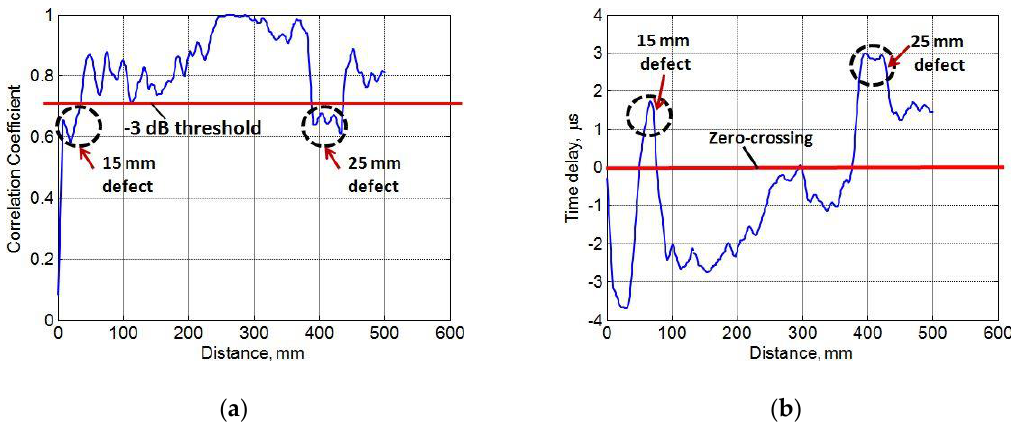
Figure 9. Defect estimation using cross-correlation procedure on wavelet-processed B-scan: ( a ) correlation between the defect-free (reference) signal to all signals; ( b ) estimating time-delays between the defect-free signal to all signals.